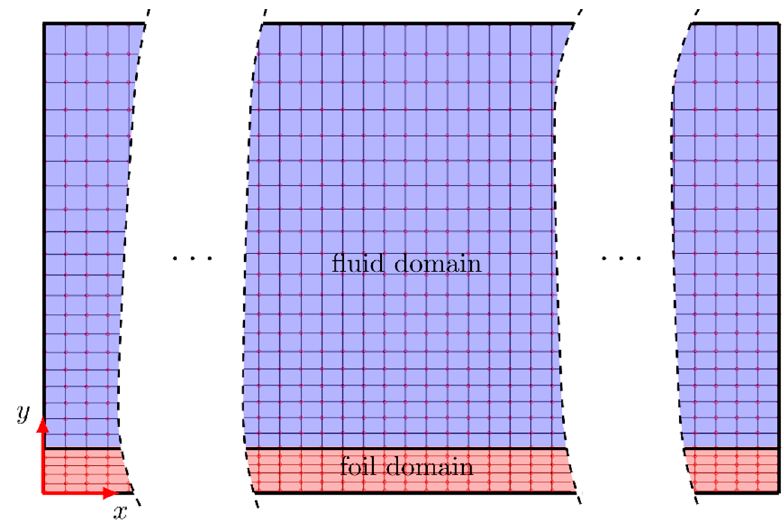
Figure 3. A typical FE mesh used in the computation in ADINA software.